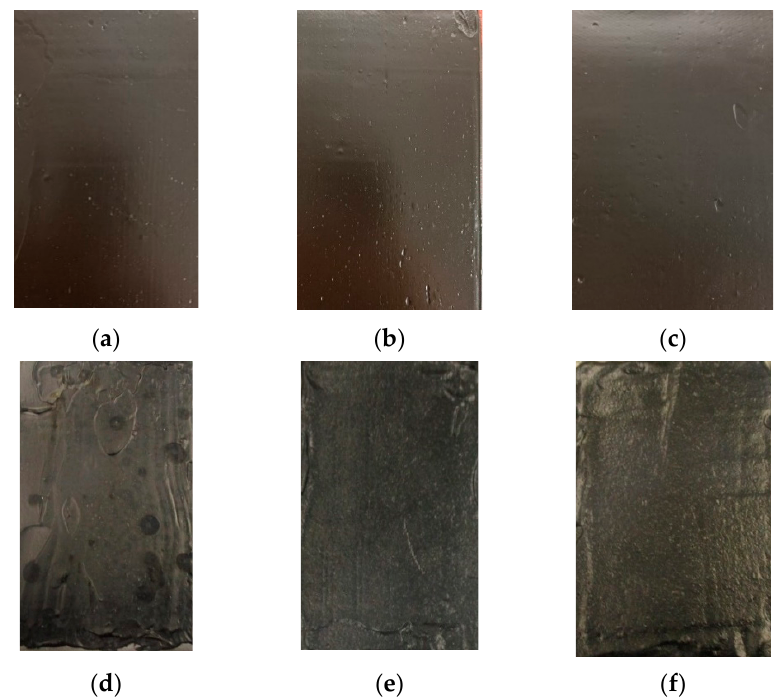
Figure 3. Optical images acquired just after preparation for the ( a ) native membrane, ( b ) MGLQ, and ( c ) MGHQ and after aging treatment for the ( d ) native membrane, ( e ) MGLQ, and ( f ) MGHQ.